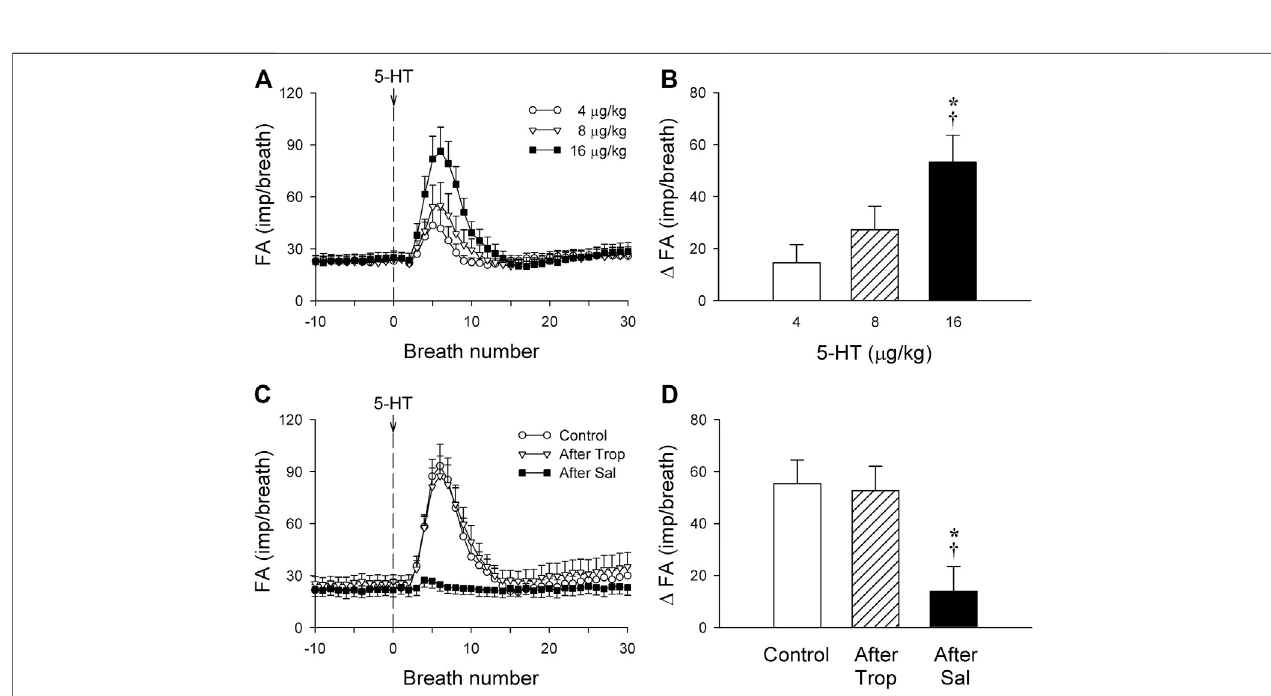
FIGURE 2 | (A) Responses of phasic RARs (n = 12) to i. v. injections (at the vertical dashed line) of increasing doses of 5-HT (4, 8 and 16 μ g/kg), separated by 15-min interval between injections, illustrated the dose-dependence of the stimulatory effect of 5-HT in anesthetized, vagotomized, open-chest, and mechanically ventilated rats. Fiber activity (FA) was measured on a breath-by-breath basis. (B) The increase in FA ( Δ FA) was the difference in FA between the baseline (20-breath average) and the peak response (average of 5 consecutive breaths) that emerged within the fi rst 20 breaths after the 5-HT injection. * and † , signi fi cantly different ( p < 0.05) from the responses to 4 and 8 μ g/kg of 5-HT, respectively. (C,D) Effect of 5-HT (16 μ g/kg) on fi ber responses of phasic RARs (n = 10) before, 15 min after pretreatment with Trop (15 μ g/kg), and 10 min after pretreatment with Sal (0.5 mg/kg). * and † , signi fi cantly different ( p < 0.05) from the control response and the response after pretreatment with Trop, respectively. Data are means ± SEM.